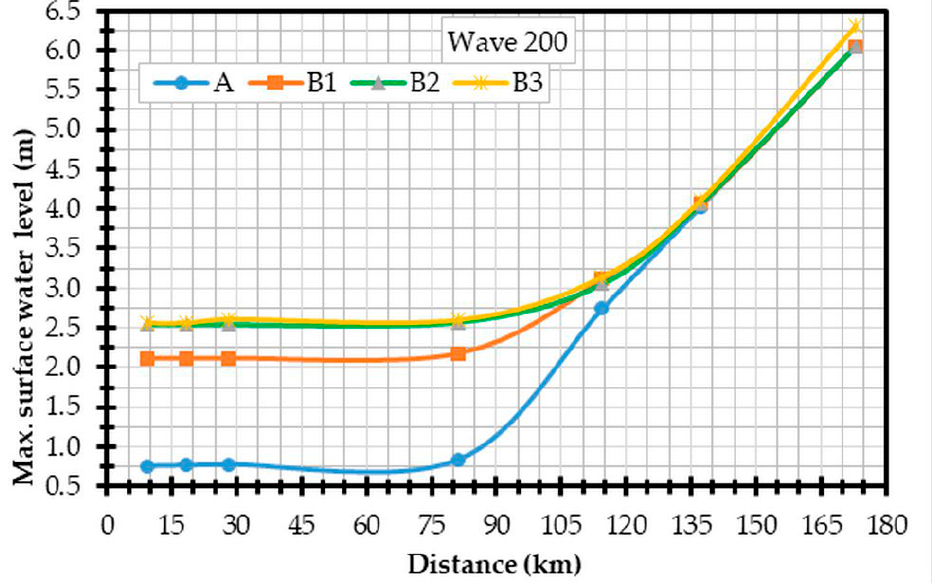
Figure 26. Water level profiles for the wave of maximum flow for the case B3.